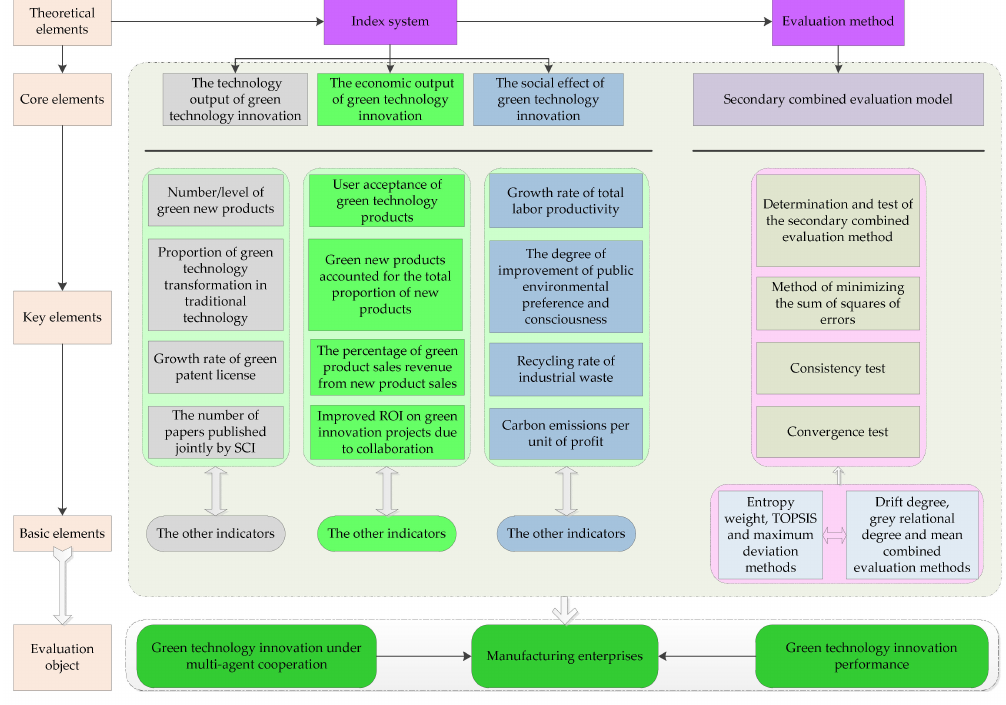
Figure 4. The theoretical framework to measure the performance of the green technology innovation of manufacturing enterprises under multi-agent